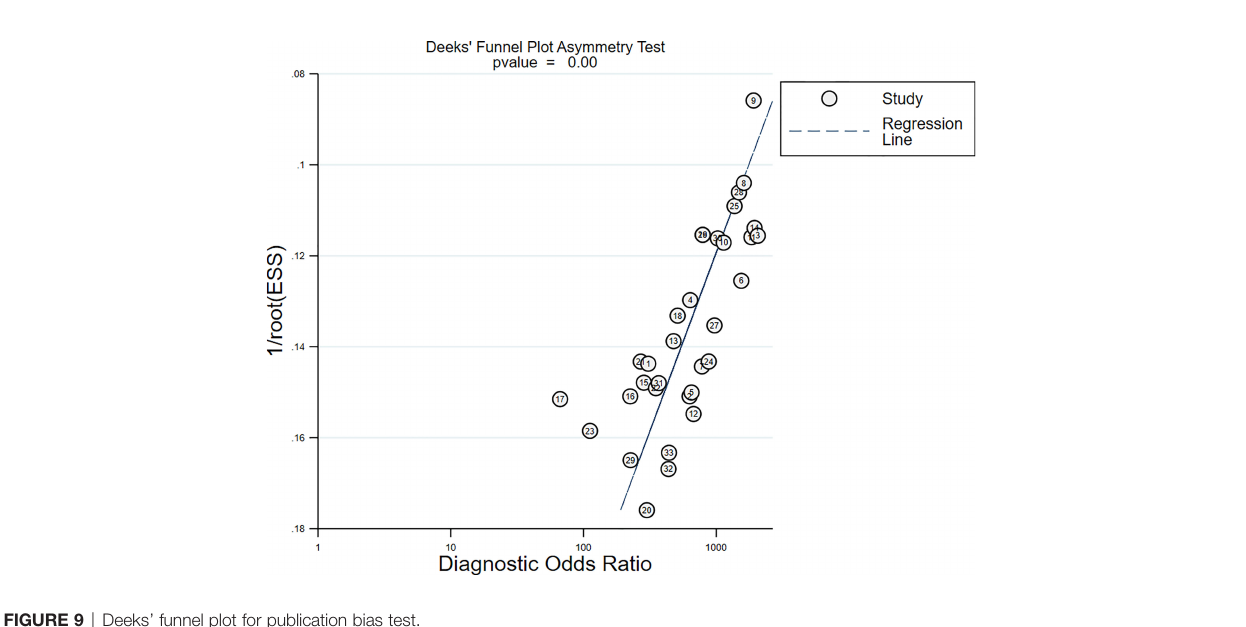
FIGURE 9 | Deeks ’ funnel plot for publication bias test.